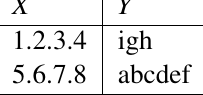
Table 4: θ = 0.4, Final clusters of the academic example of Figure